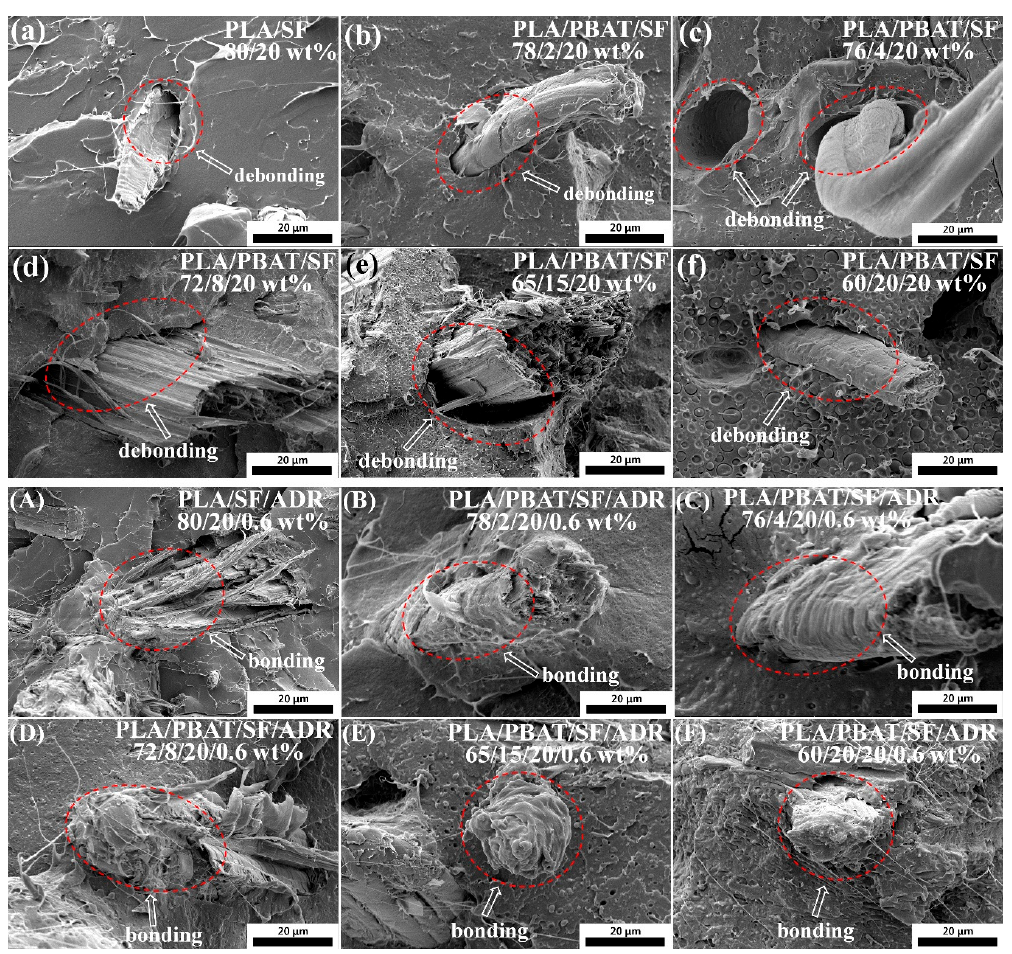
Figure 2. Fiber morphology on impact fracture surfaces PLA / SF composites ( a ); PLA / PBAT / SF composites ( b – f ); PLA / SF / ADR composites ( A ); PLA / PBAT / SF / ADR composites ( B – F ). 5000 ×